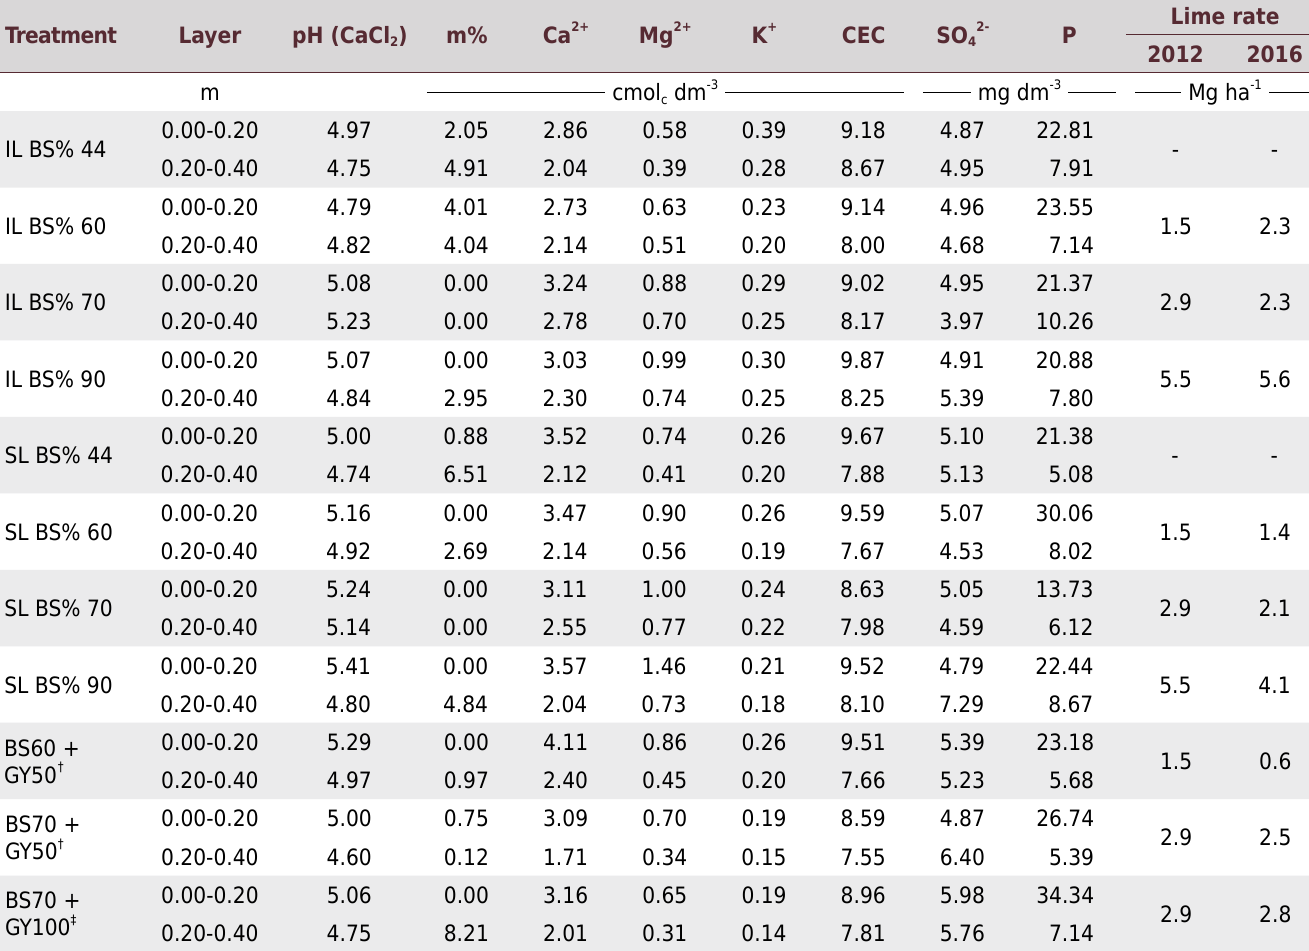
Table 2. Chemical characterization was performed in 2016 (4 years after the 1st lime application) to define the doses reapplied in 2016. Doses of lime were applied in 2012 and 2016 and considered the total rate required to reach the desired base saturation (BS%) Treatment Layer pH (CaCl 2 ) m% Ca 2+ m